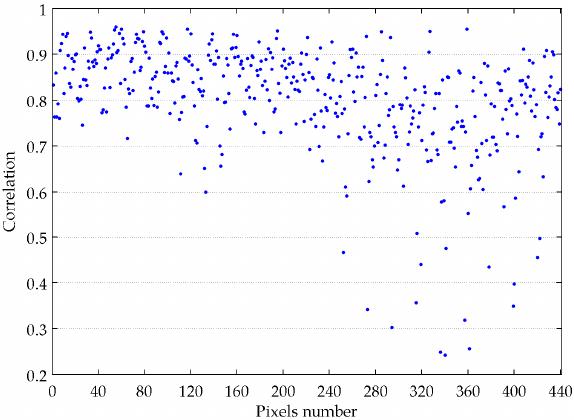
Figure 9. Correlation coefficients between the inspected time series and the neighboring time series.